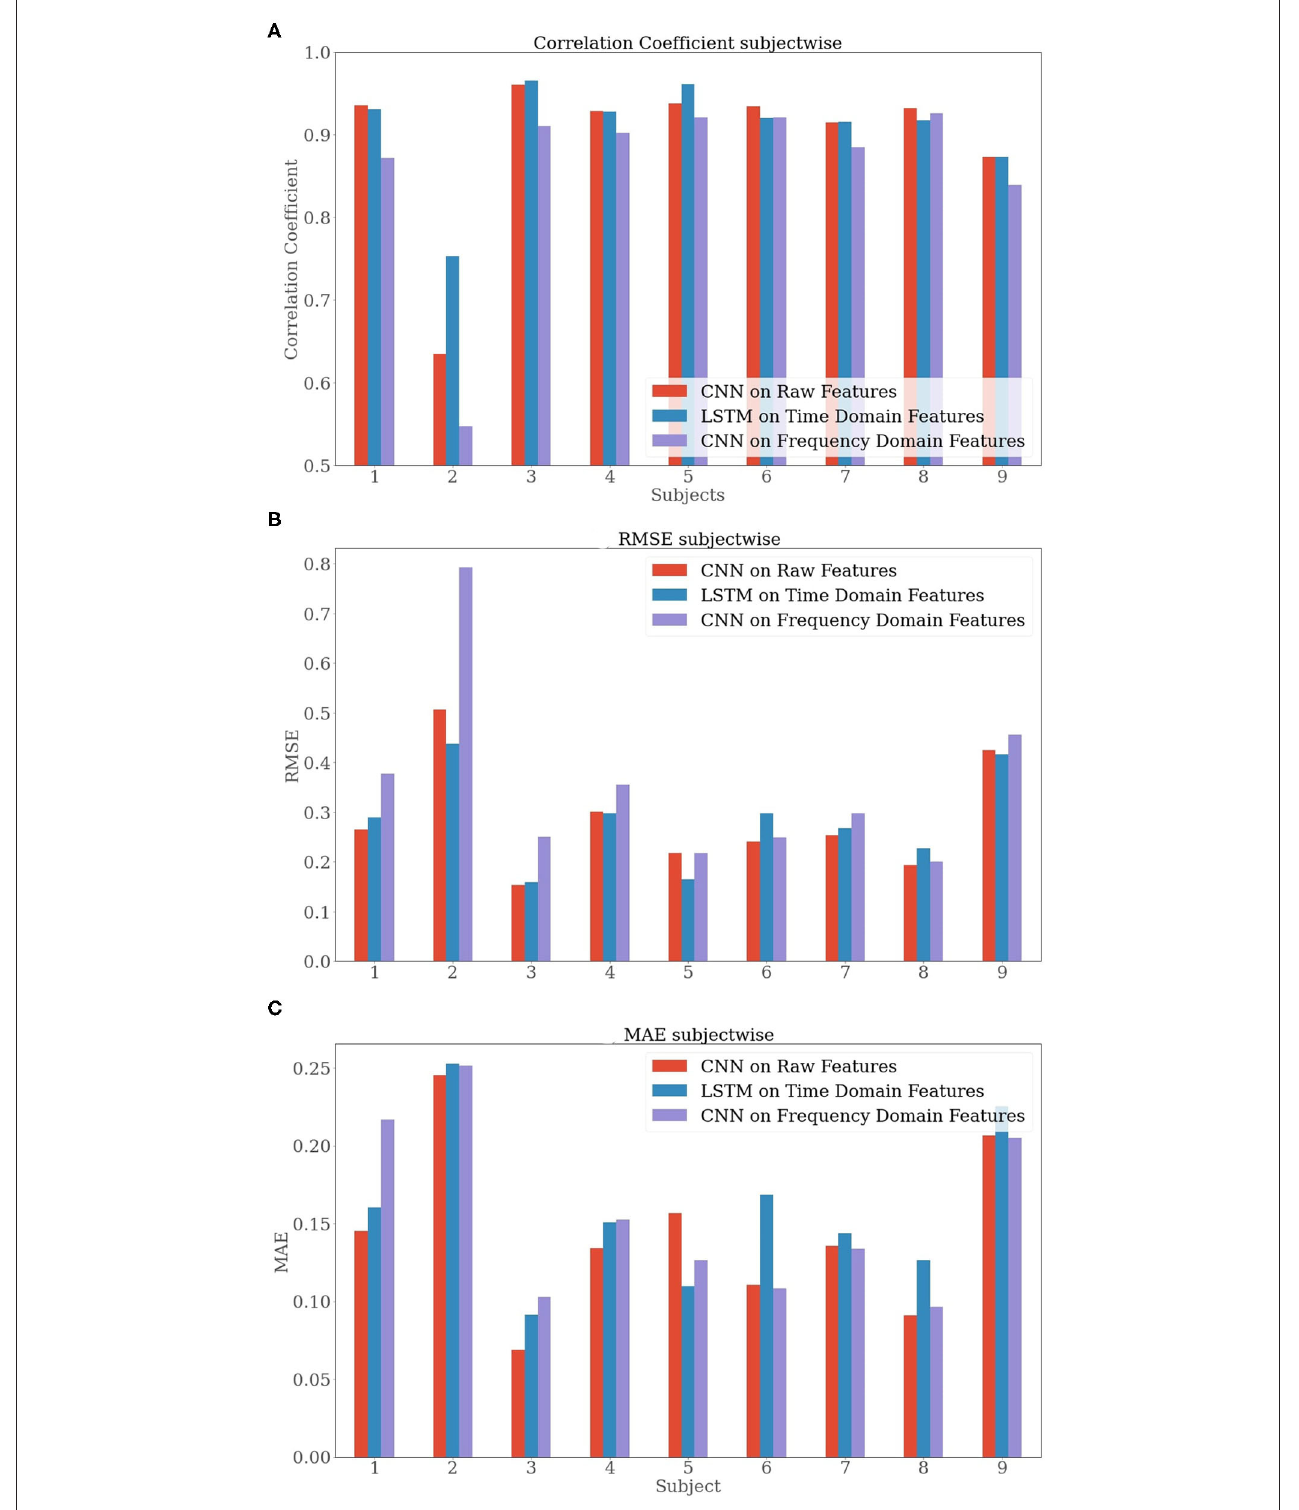
FIGURE 6 | Bar plots of the subject-wise evaluation metrics (A) Correlation Coefficient, (B) RMSE, and (C) MAE) averaged over a 3-fold cross-validation.